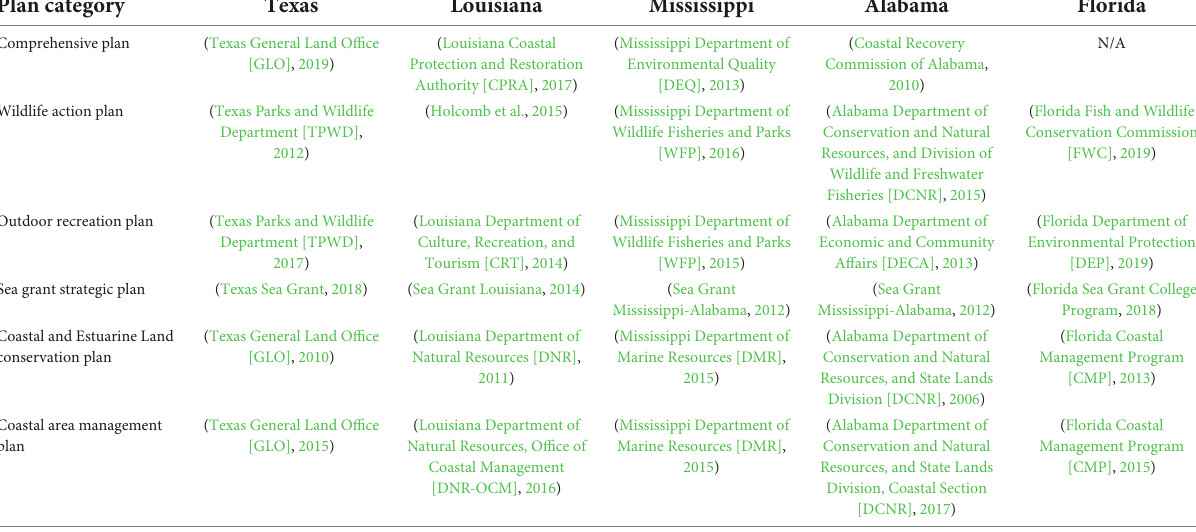
TABLE 1 List of management plans ( n = 29) from five Northern Gulf of Mexico states that were reviewed for this qualitative analysis. Plan